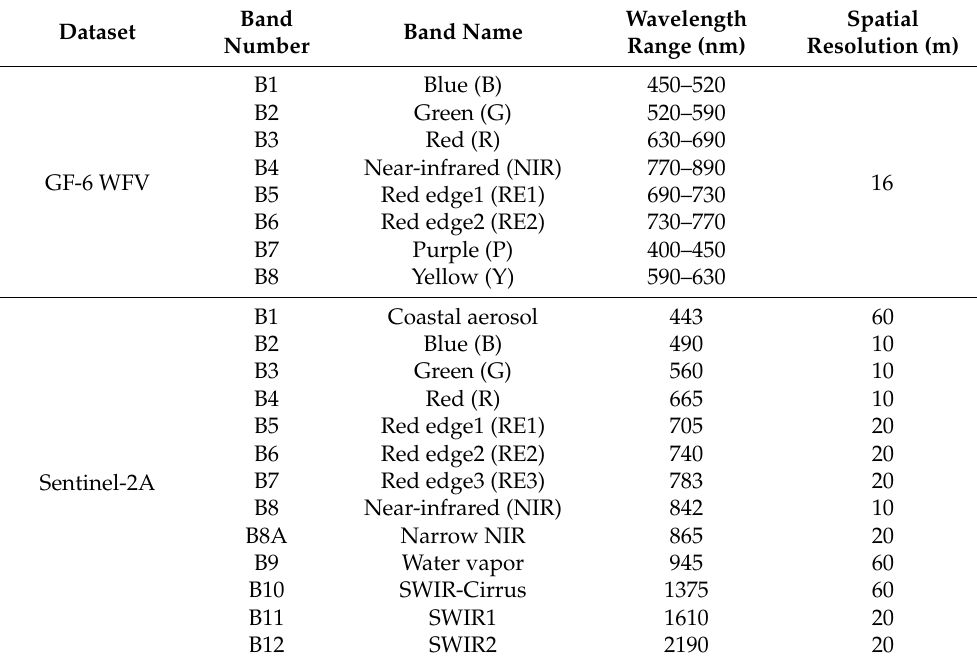
Table 2. Main information parameters of GF-6 WFV and Sentinel-2A